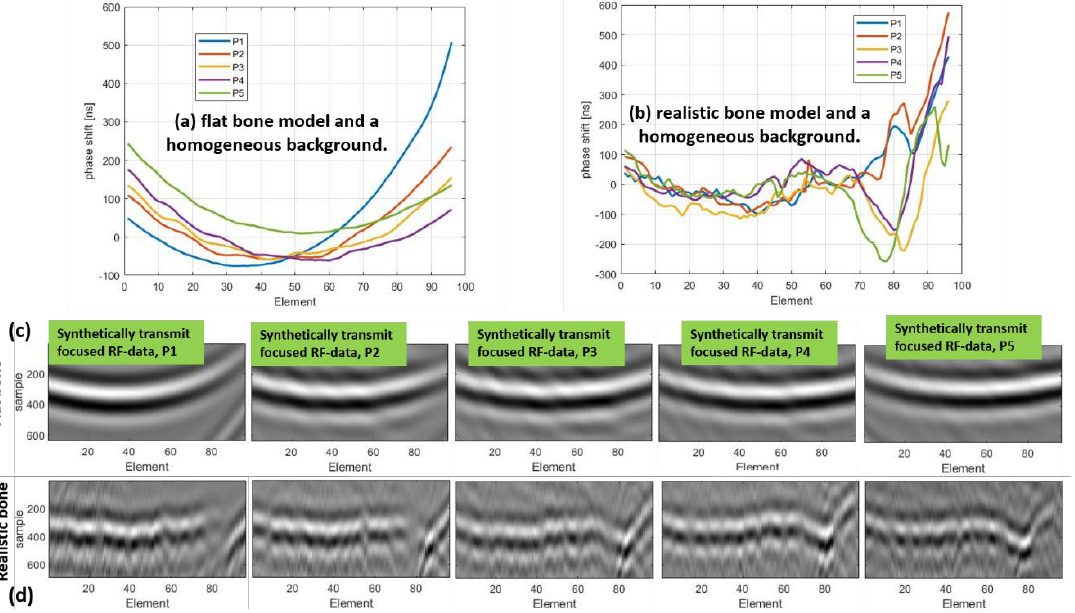
Figure 4. The aberration profile in five isoplanatic patches (indicated by P) when the aberrator/background model is ( a ) flat/homogeneous and ( b ) realistic/heterogeneous. The extracted synthetic-transmit-focused RF data in different isoplanatic patches for the ( c ) flat bone and ( d ) realistic bone model; the background was homogeneous.